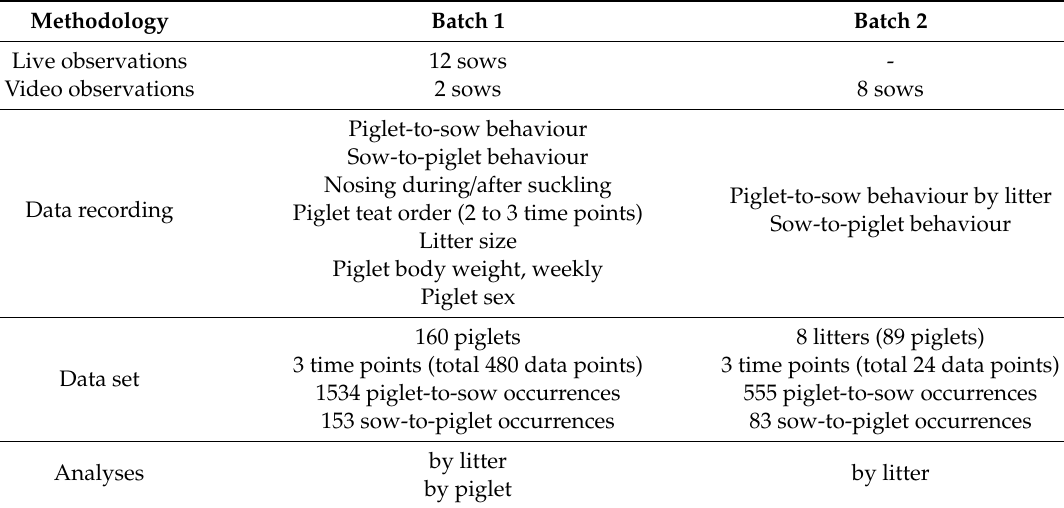
Table 1. Overview of data collection across farrowing groups (i.e.,